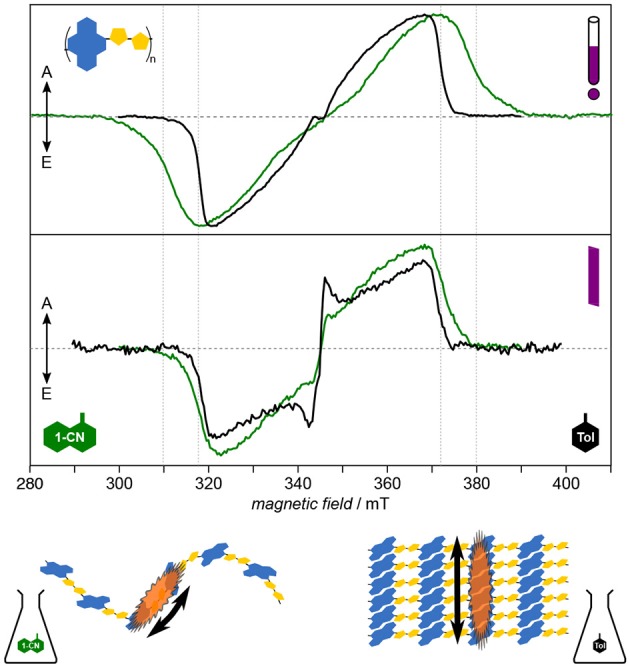
Solution morphology: Solvent-induced aggregate formation in PNDIT2 results in a change in exciton delocalization mode. Already from first inspection, the dramatic difference of the TREPR spectra in both solvents is apparent (upper panel). Careful analysis of the data reveals PNDIT2 to form highly ordered aggregates in toluene (Tol) solution. Additionally, the mode of exciton delocalization changes from intrachain in 1-chloronaphthalene (1-CN) to interchain in toluene (lower panel). Interestingly, the width of the spectra in toluene solution coincide with those obtained for films cast from either solvent (middle panel). This can be explained by PNDIT2 to form aggregates in the film, as known from the literature. All TREPR spectra have been recorded at 80 K and X-band frequencies (about 9.7 GHz). For details see Meyer et al. (2018a).